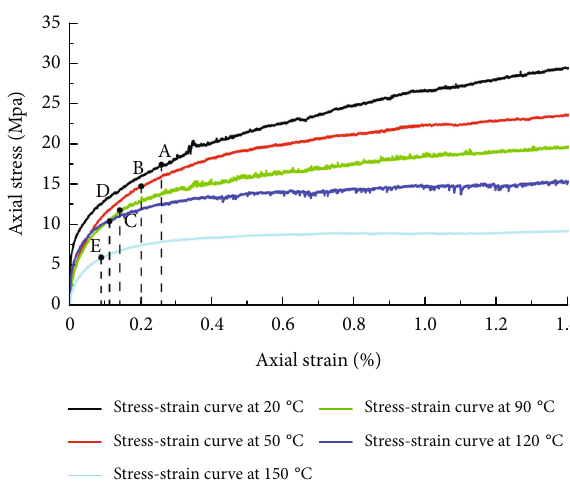
Figure 5: Stress-strain simulation curves of salt rock samples at di ff erent temperatures.